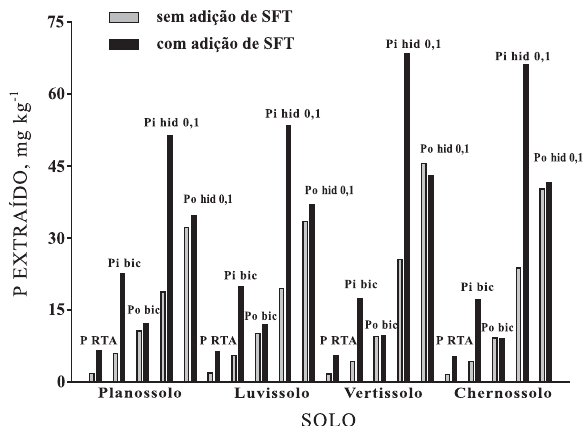
Figura 1. Teores de fósforo nas frações de amostras do Planossolo, Luvissolo, Vertissolo e Chernossolo sem e com a adição de fósforo (SFT). P-RTA: P-Resina; Pi-Bic: Pi-Bicarbonato; Po-bic: Po-Bicarbonato; Pi-hid 0,1: Pi-hidróxido 0,1 mol L -1 ; Po-hid 0,1: Po-hidróxido 0,1 mol L -1 .